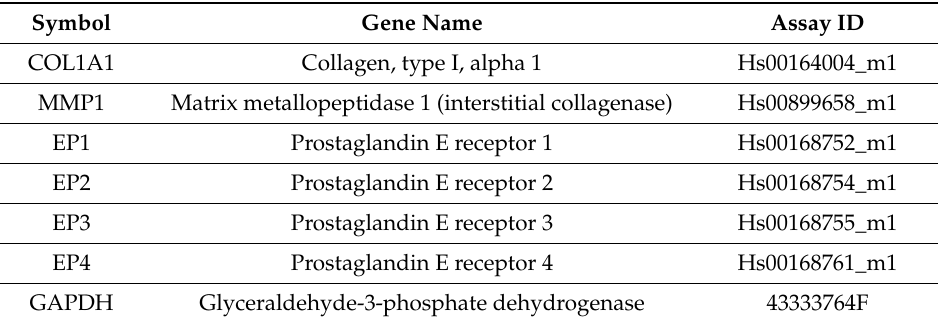
Table 1. Gene Name and Assay ID Number in Real-time RT-PCR